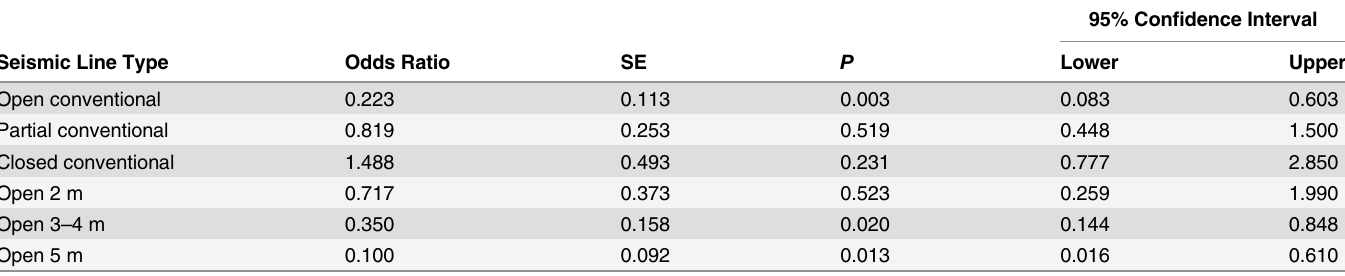
95% Con fi dence Interval